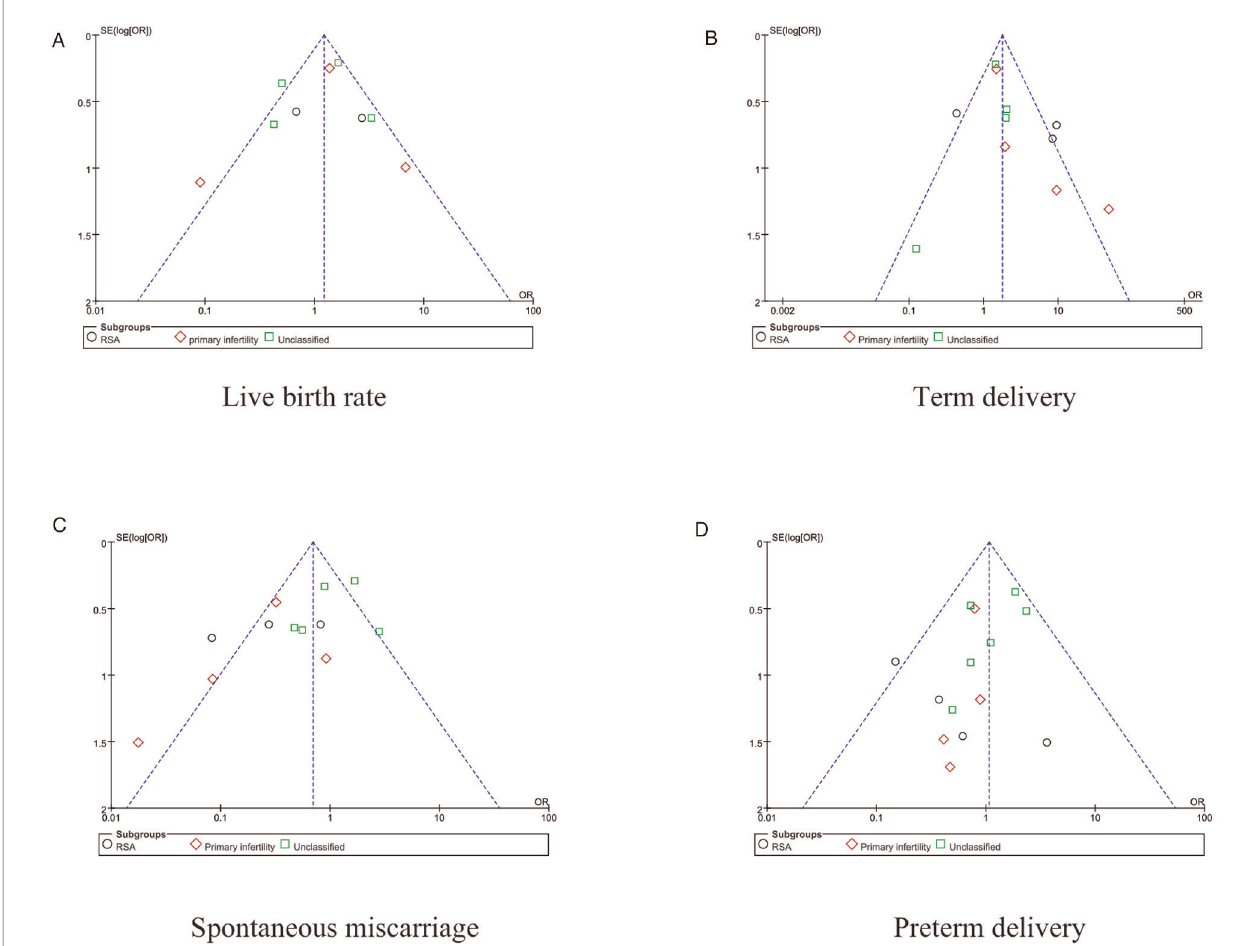
FIGURE 2 | Funnel plot of the meta-analysis for ( A ) Live birth rate, ( B ) Term delivery, ( C ) Spontaneous miscarriage and ( D ) Preterm delivery.